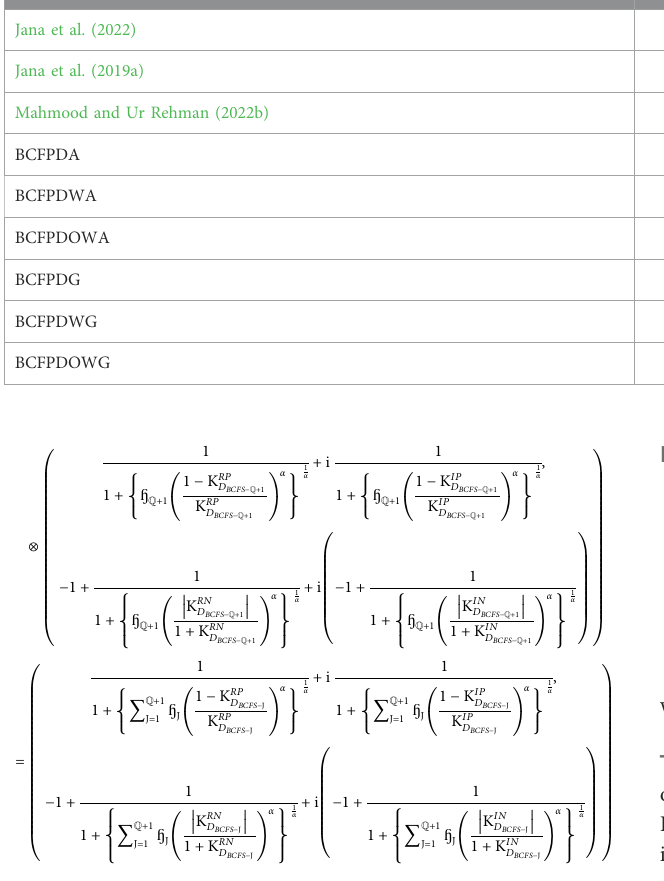
TABLE 14 Ranking order relies on the score values achieved in Table 13. Method Ranking Jana et al.